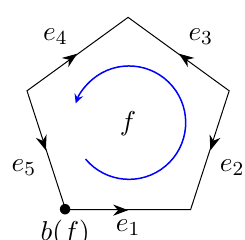
Figure 5 . Definition of the action of π 1 ( B ; C ) on π 2 ( A, B ; C ) . Here γ is a path from c 0 to c and σ belongs to π ( A, B ; c 0 ) . 2